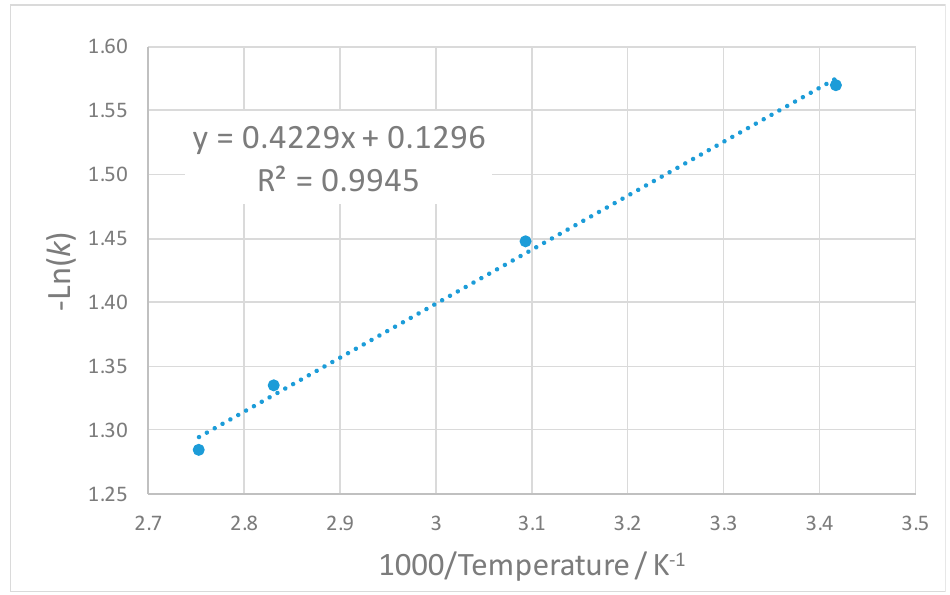
Figure 6. Arrhenius plot for the data in Table 3. Molar liquid to solid ratio: 9.88 (mol DES/mol initial Cu in chalcopyrite).